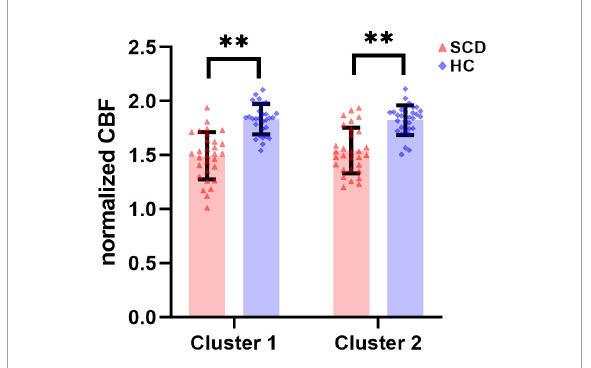
FIGURE3 There were statistically significant differences in normalized CBF of ROI-based Cluster 1 and Cluster 2 between the SCD group and the HC group. SCD, spinocerebellar degeneration. ∗∗ indicates P < 0.0001.